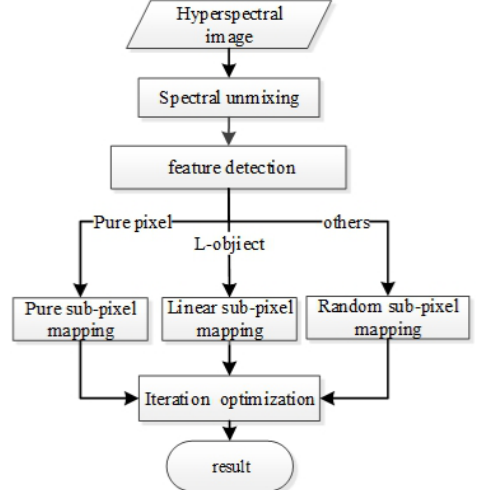
Figure 1. The flowchart of the proposed method